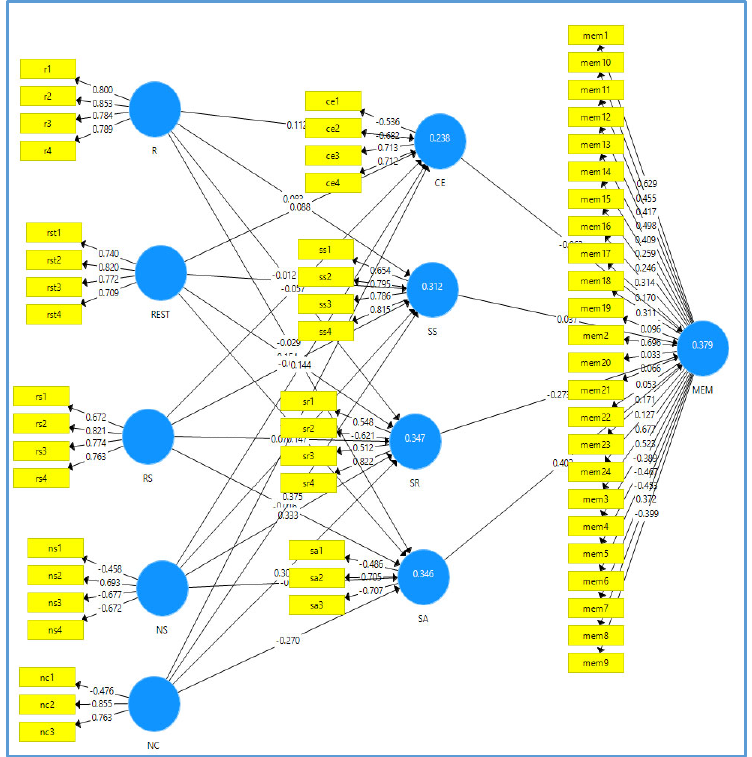
Fig. 3. Results of the structural